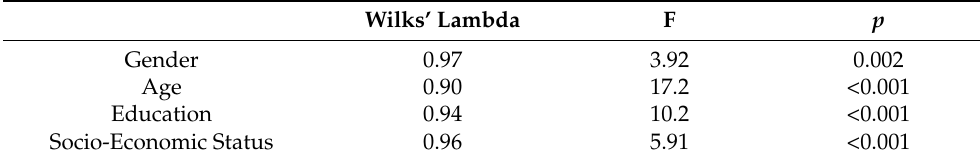
Table 4. MANOVA’s Multivariate